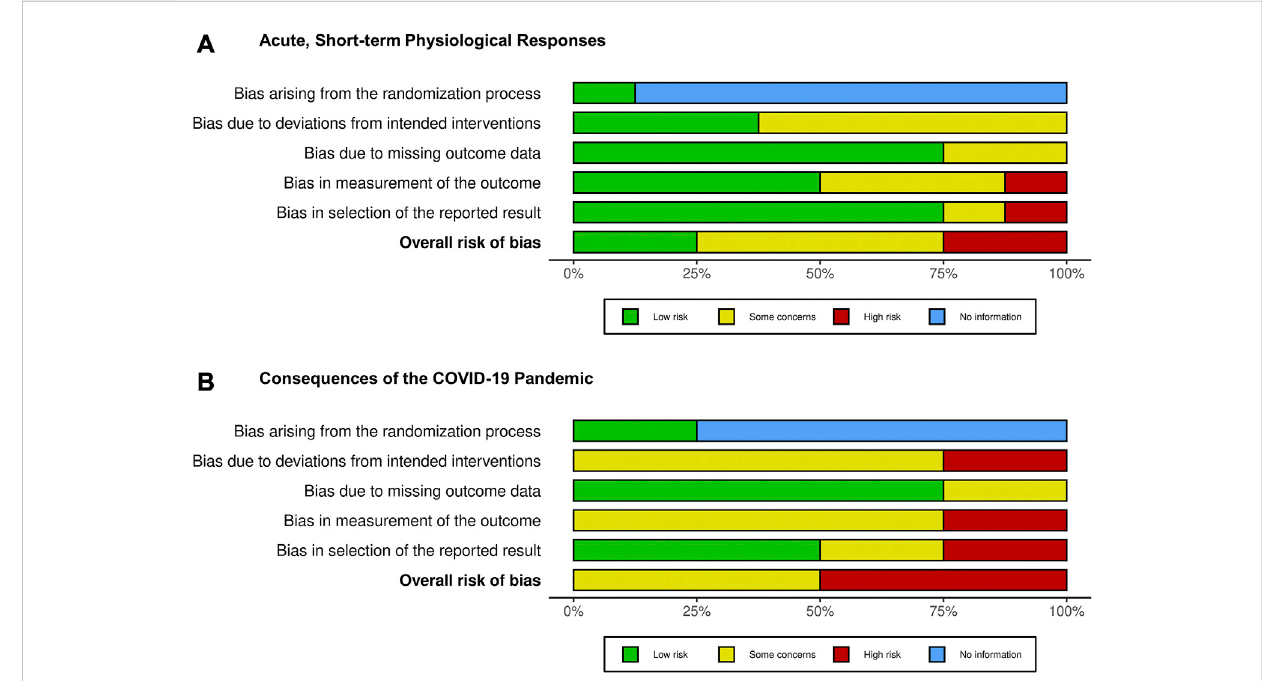
FIGURE 2 Cochrane risk of bias assessment across the included studies from Part (A) and Part (B) of the systematic